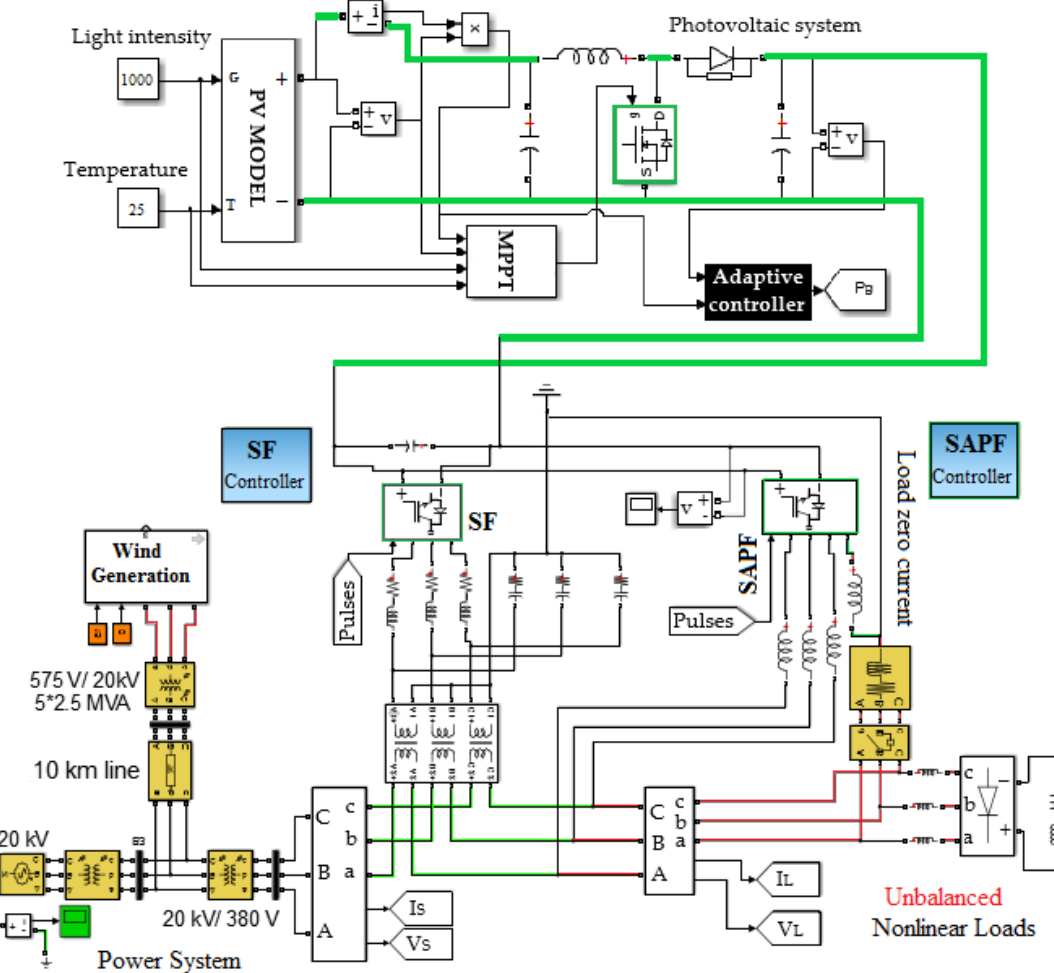
Figure 12. Simulation of interfaced photovoltaic (PV)-based DC micro-grid with power system, including a wind generator, by proposed UPQC.